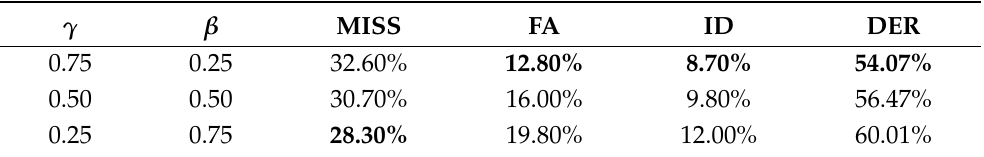
Table 3. Experimental results of RTVE 2020 Multimodal Diarization test set, showing DER% and decomposition of DER% results in miss (MISS), false alarm (FA), and identity (ID) errors. These results were obtained by sweeping the parameters of the aDCF loss function. The best results are marked in